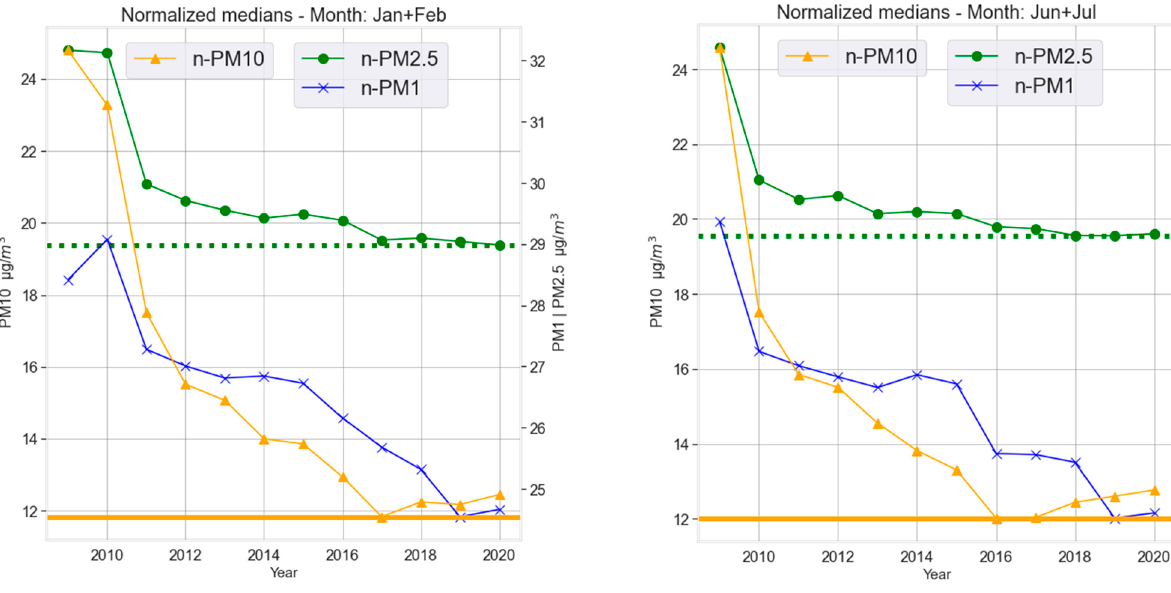
Figure 6. ( a ) Normalized medians for January and February (CS) during 2009–2020, ( b ) Normalized medians for June and July (NNS) during 2009–2020. The green line is PM 10 related to the respective right axis, while blue and orange are PM 1 and PM 2.5 mass concentrations respectively referred to the left axis. The horizontal lines present the lowest values for the axes respectively.